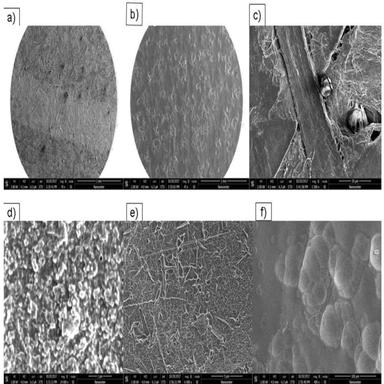
SEM-EDXS micrographs of the SLO paper: upper surface at low magnification a), food-facing surface at low magnification b), upper surface at higher magnification with print spot c), upper surface with partly printed area at different magnification c) and d), food - facing surface at different magnification e) and f).